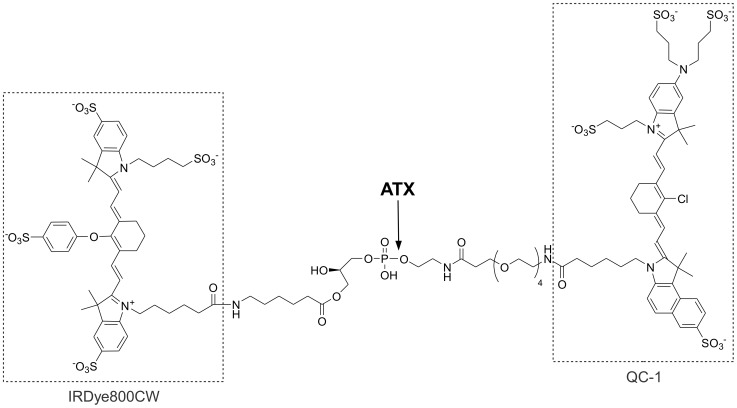
Structure of AR-2.